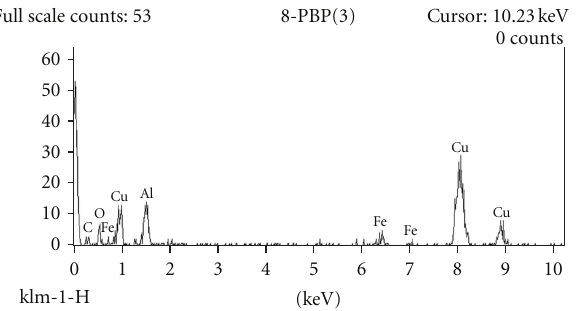
Figure 3: TEM EDS (energy dispersive spectrum) pattern of Fe 40 Al 60 particles before corrosion electrochemical